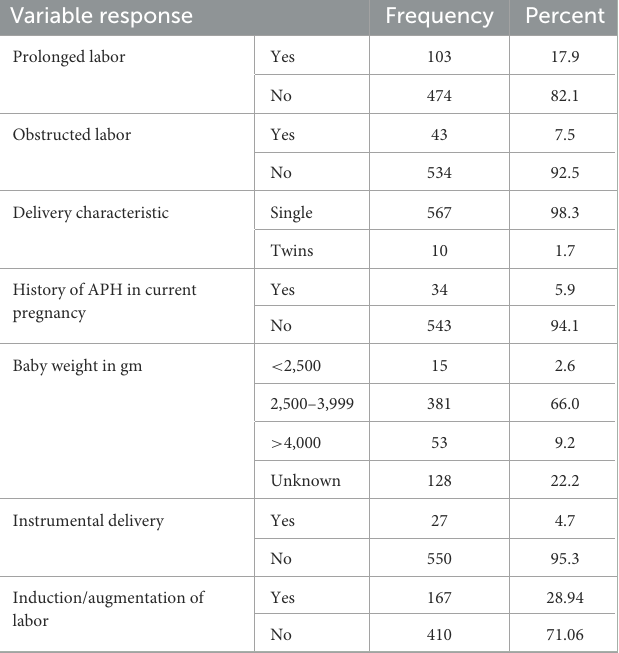
TABLE 3 Distribution of delivering women by their current obstetric condition in the district areas health centers of Gedeo Zone, Southern Ethiopia, 2021 ( N = 577).